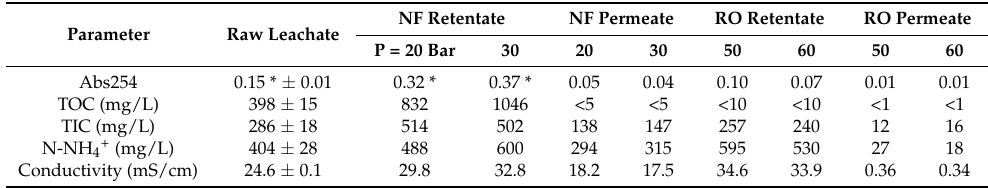
Table 6. Measured parameters in feed, retentate and permeate samples from scheme 1—NF (20 bar) → RO (60 bar) and NF (30 bar) → RO (50 bar).